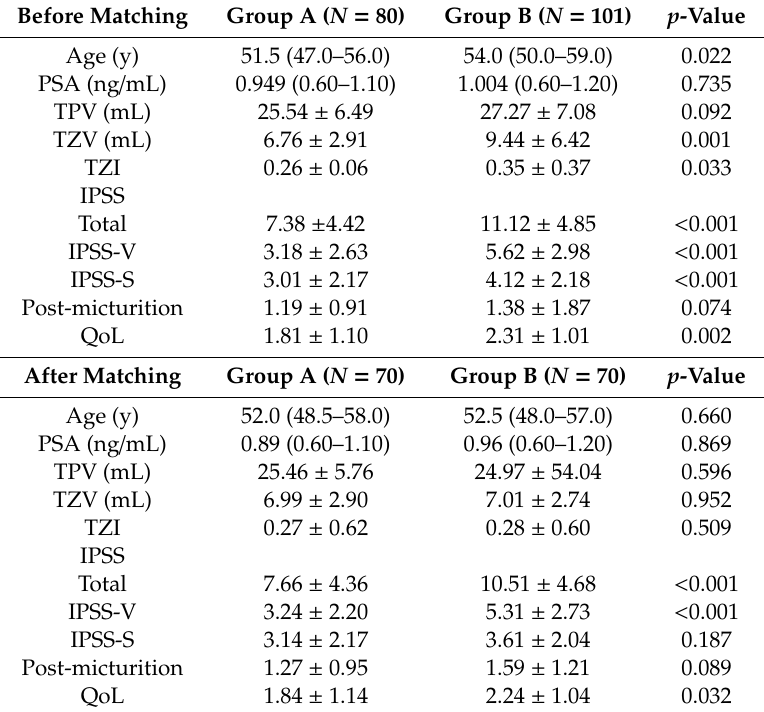
Table 2. Comparison of prostatic parameters and urinary symptoms by periurethral sti ff ness before and after propensity score matching.